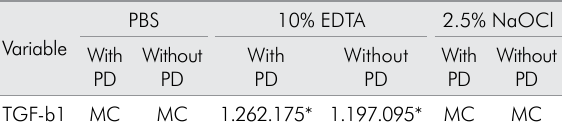
Table 1. Estimated TGF- b 1 concentration (pg/mL) in the medium conditioned by tooth slices either containing or not containing the predentin layer (PD) and treated with PBS, 10% EDTA or 2.5% NaOCl.